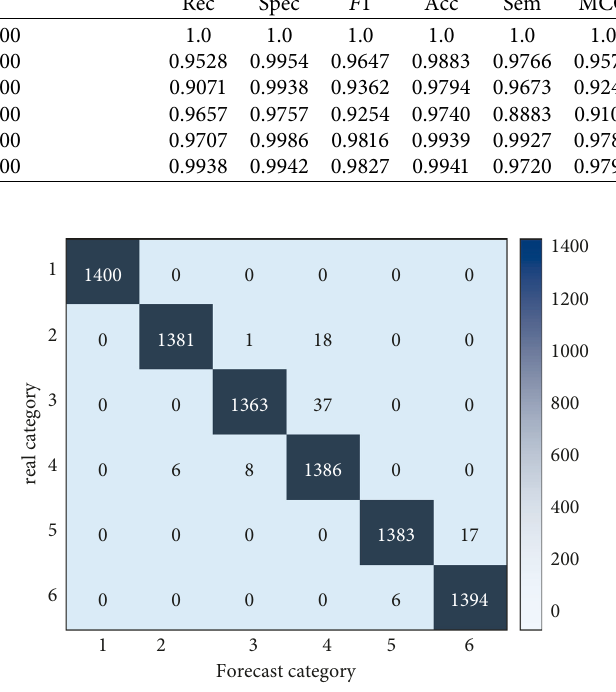
Figure 8: Individual recognition results of XGBoost mobile devices.